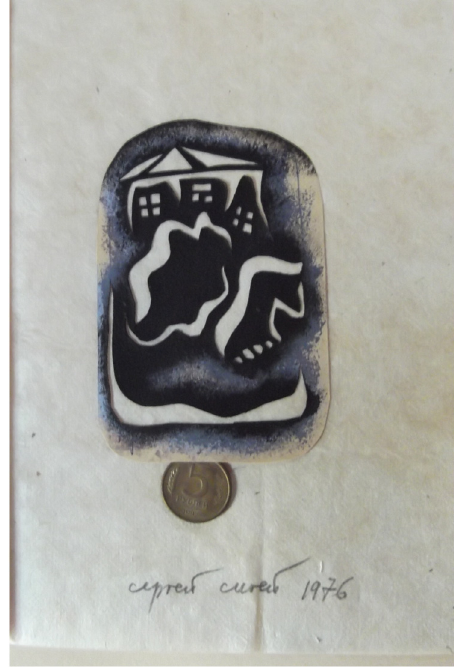
Figure 13. Inside of the box.